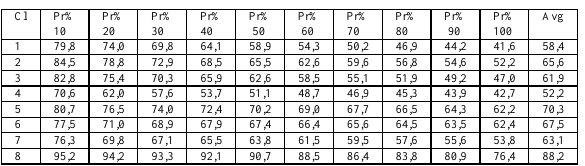
Table 2. Average precision values for each category.